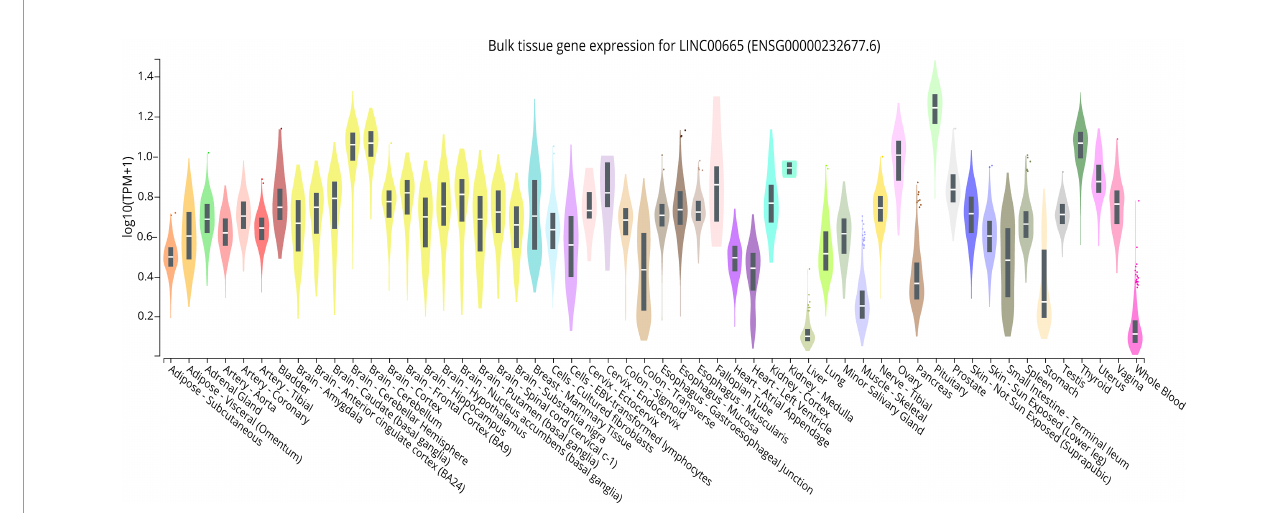
FIGURE 2 | LINC00665 expression in various kinds of human normal tissues (data from